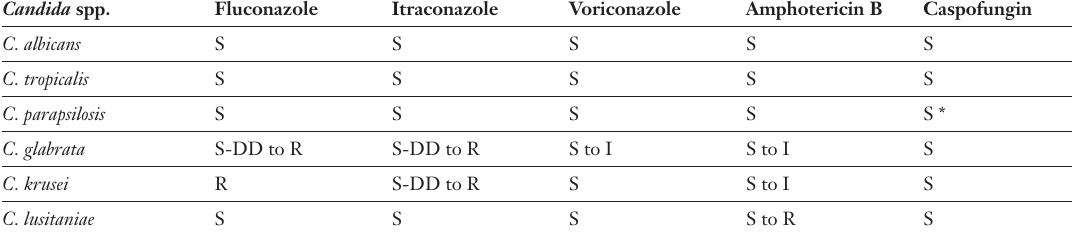
General pattern of susceptibility of Candida species (adapted from